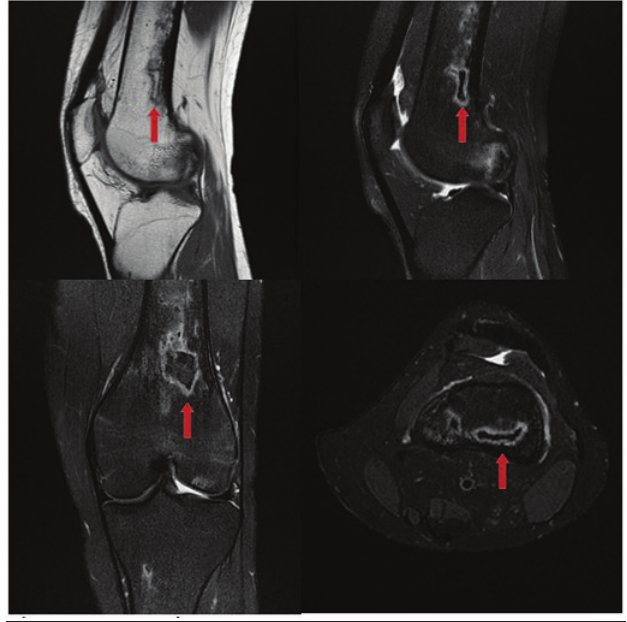
figurE 4 − MNR in BMN 1: upper left to lower right – MNR sagittal T1, sagittal, coronal, and axial T2 with fat saturation. A patient with dermatomyositis diagnosed with BMN. Red arrows indicate areas of increased liquid content MNR: magnetic nuclear resonance; BMN: bone marrow necrosis.